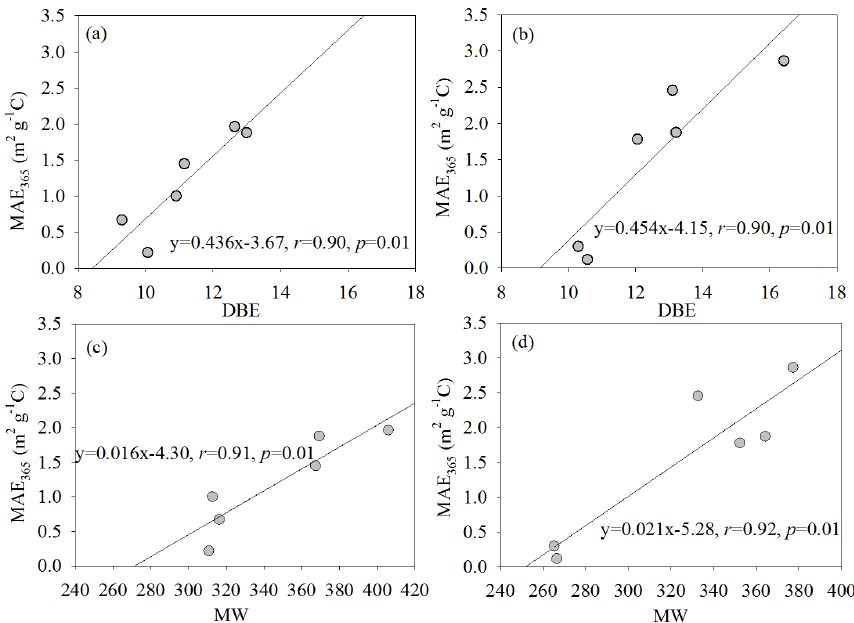
Figure 7. Relationships between DBE and MW of the potential BrC molecules and the MAE 365 of WSOC (a, c) and MSOC (b, d) from the six aerosol samples,